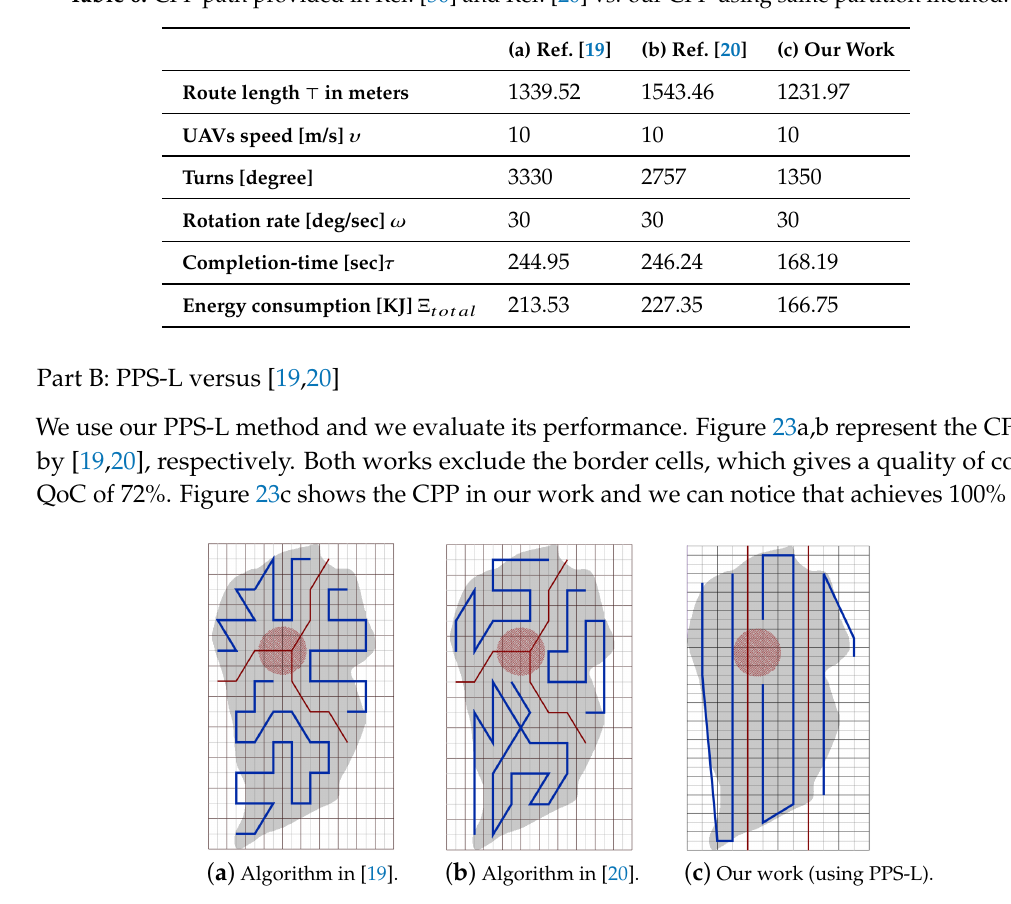
Table 6. CPP path provided in Ref. [30] and Ref. [20] vs. our CPP using same partition method.